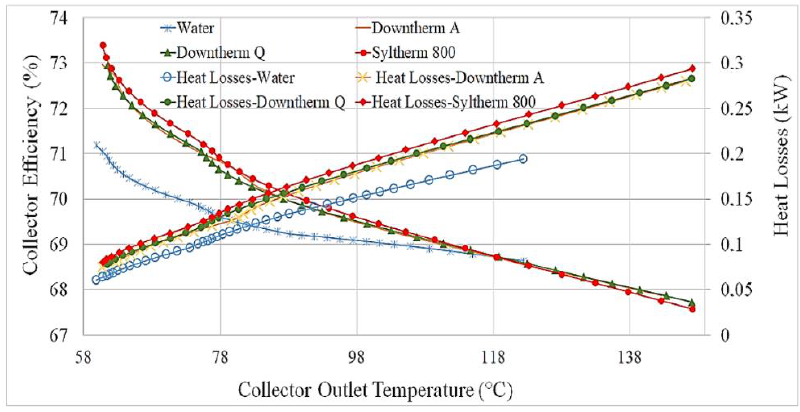
Figure 6. Efficiency and heat losses in the solar field.